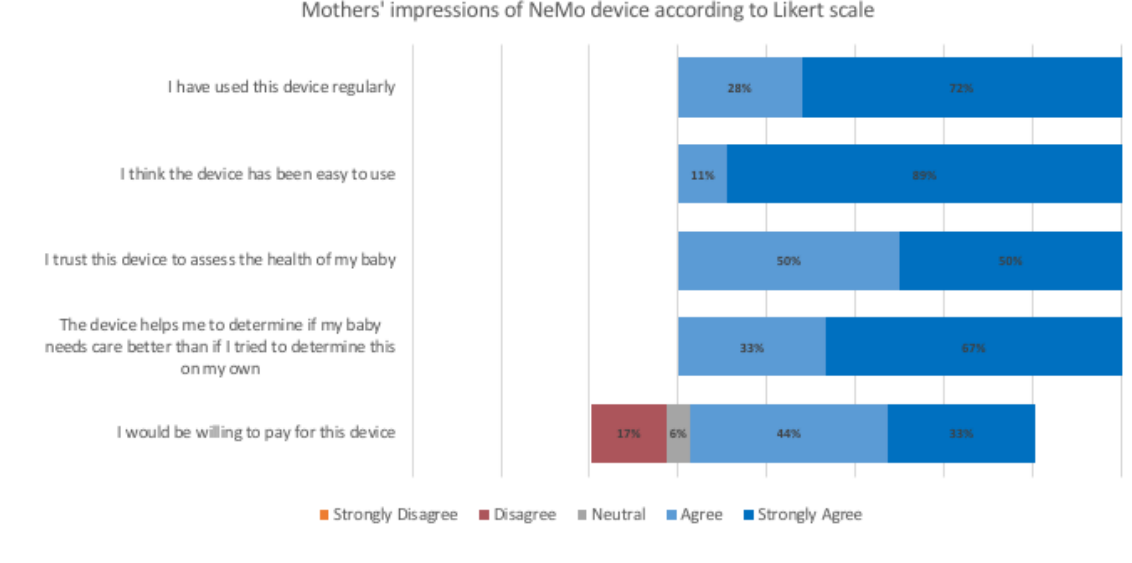
Figure 8. Mothers’responses to Likert scale statements regarding their experience using the device after 6